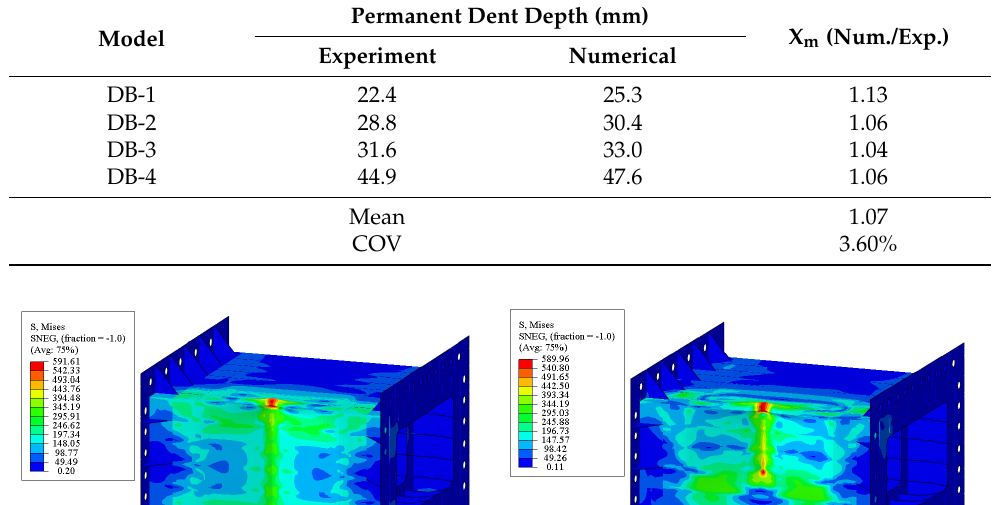
Table 6. Comparison of the numerical predictions with the experiment results: Denting damage. Model